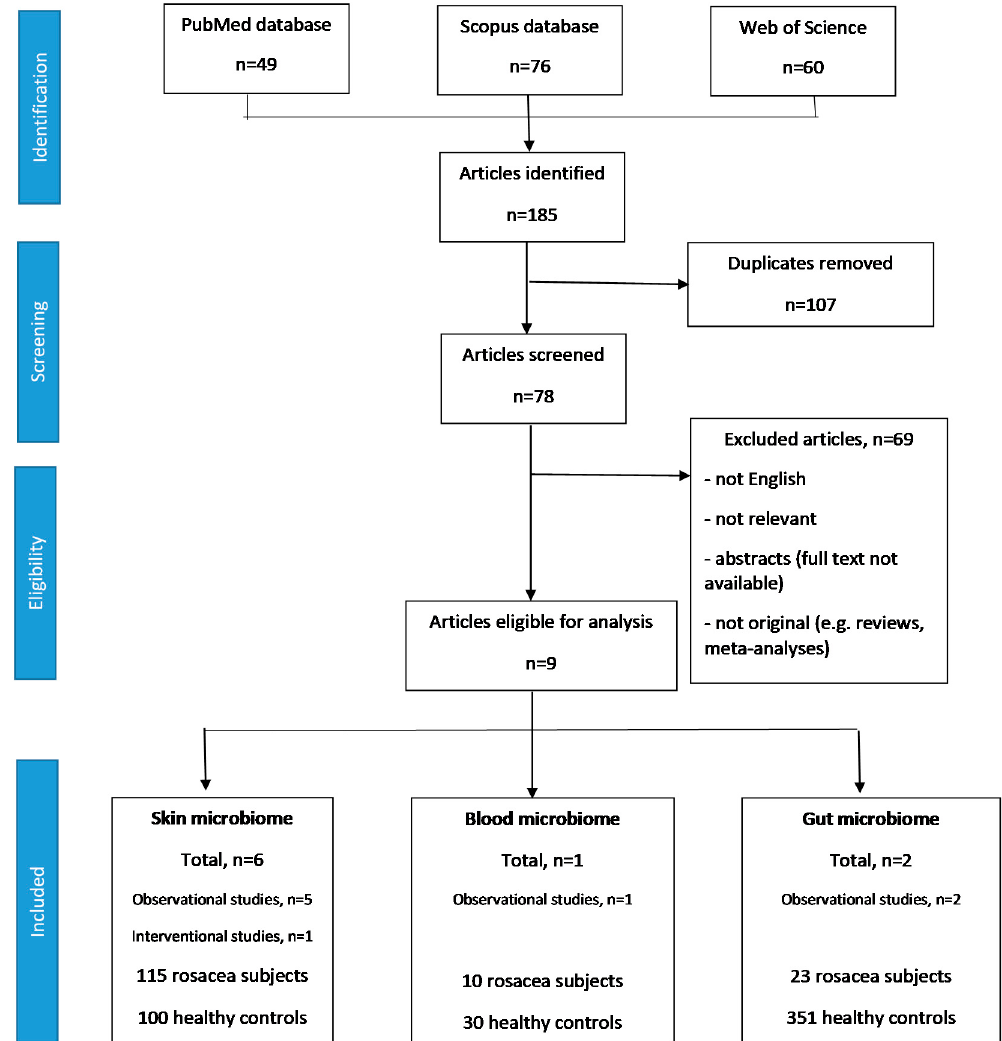
Figure 1. The PRISMA flowchart of literature search and selection.